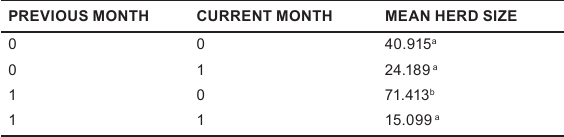
Table 2 Relationship between herd size of springbok and rainfall in the Kalahari Gemsbok National Park during the study period from November 2002 to May 2004.